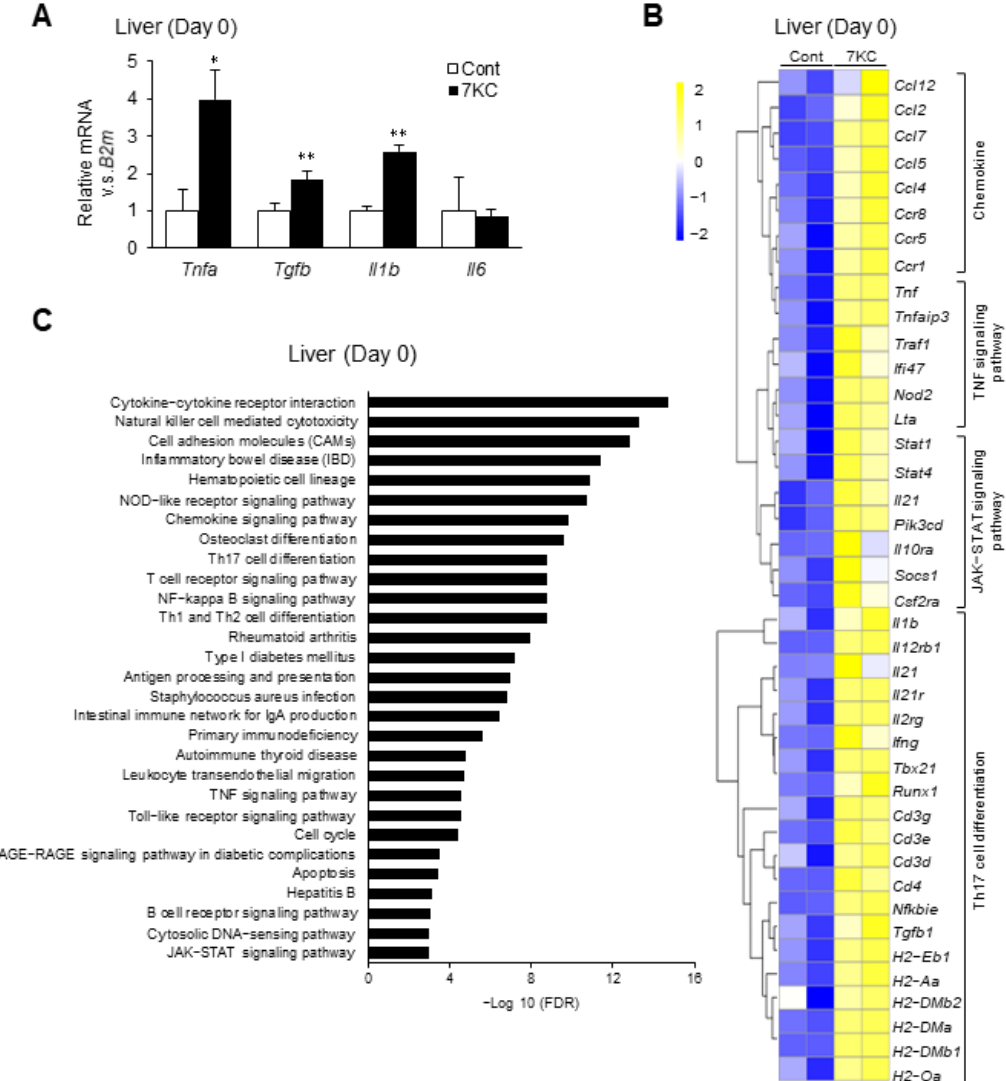
Figure 2. The 7KC-containing diet enhanced inflammatory responses in the liver. ( A ) mRNA expression of inflammatory genes was examined on Day 0 using quantitative PCR. Mean expression